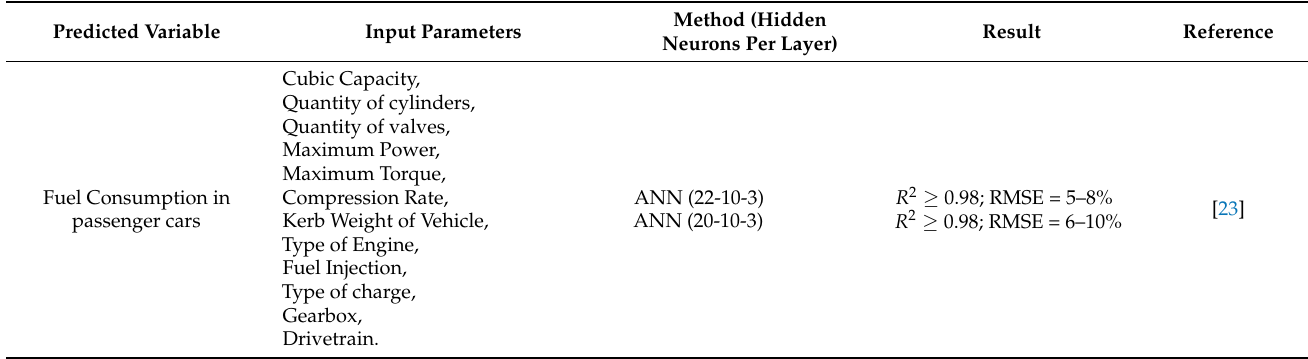
Table 1. Comparison of research results from previous